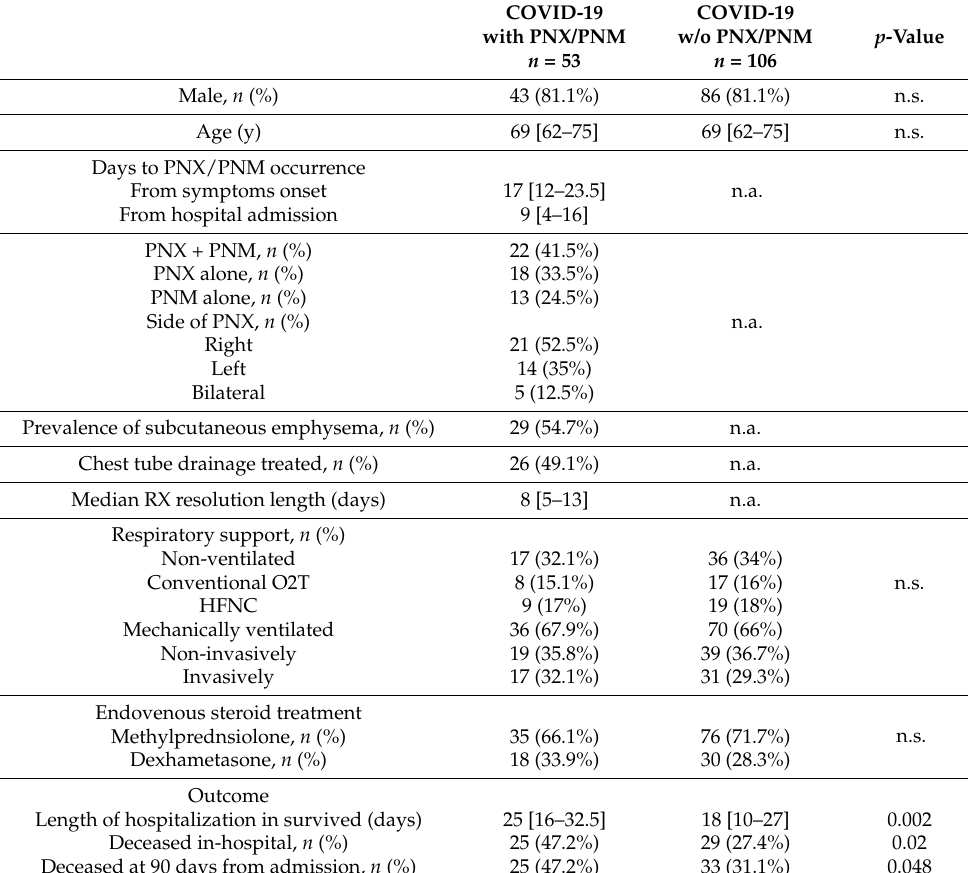
Table 1. Demographics, clinical characteristics, and outcome of COVID-19 patients with and without